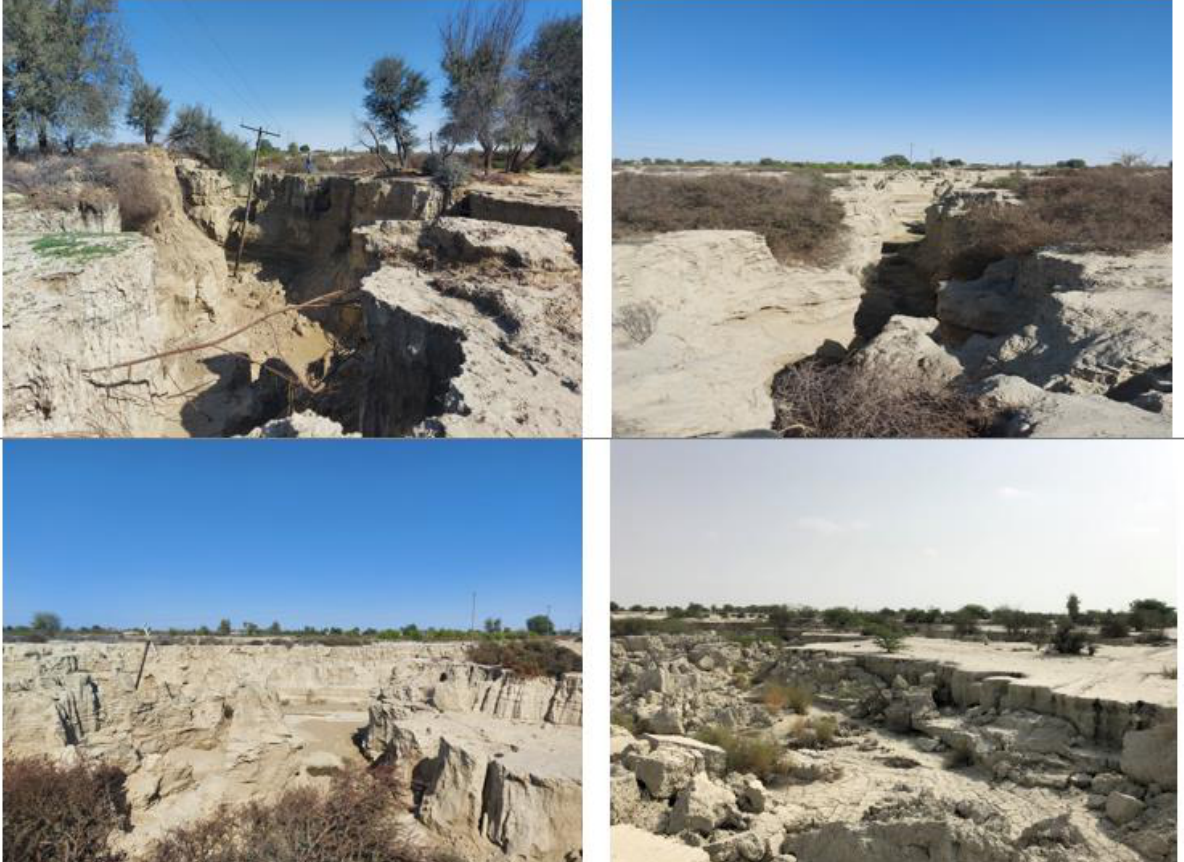
Figure3. The gully erosion in the study